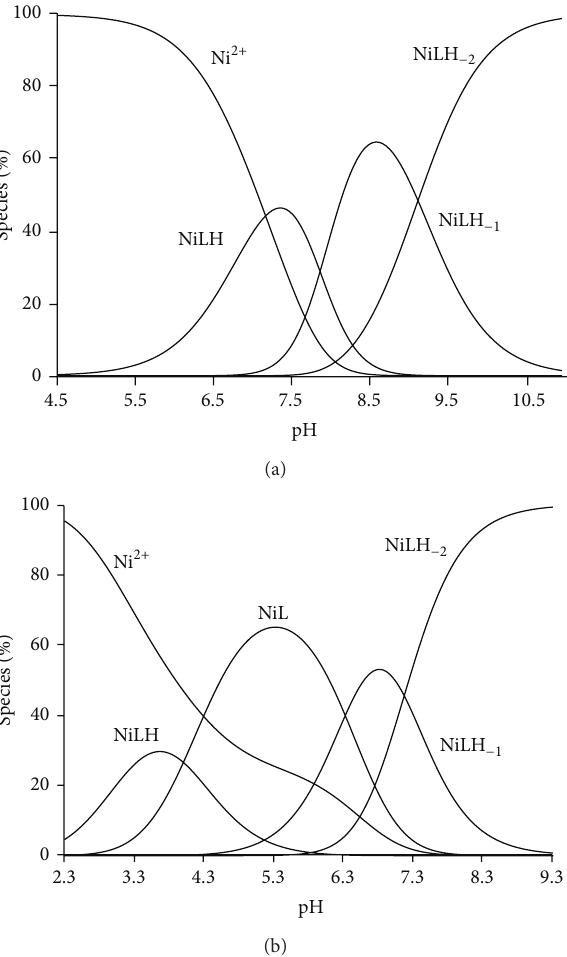
Figure 3: (a) Calculated speciation distribution graphs for a Ni(II)- L1 solution ([M] = 0.00051 mol dm −3 and [L] = 0.00101mol dm −3 ) as a function of pH. (b) Calculated speciation distribution graphs for a Ni(II)-L3 solution ([M] = 0.00051 mol dm −3 and [L] = 0.00101 moldm −3 ) as a function of